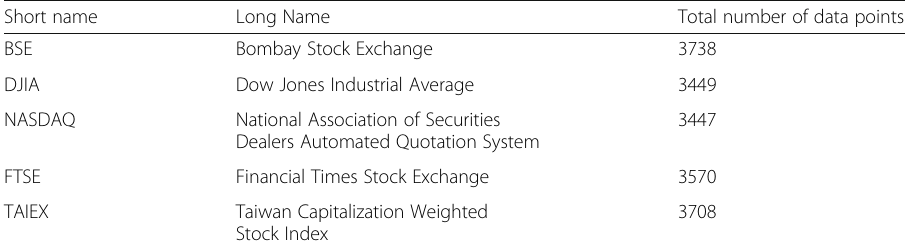
Table 2 Datasets considered for experiment